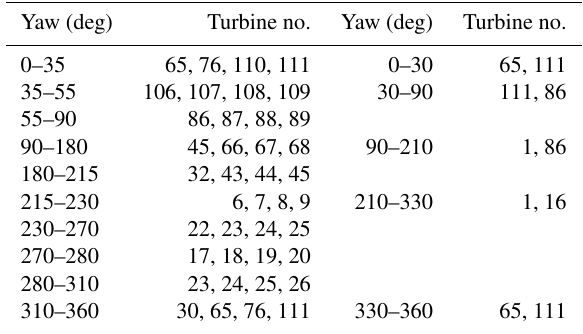
Table 1. Free-stream turbines used to determine the inflow wind speed (first two columns) and the inflow wind direction (second two columns) as a function of an average yaw position. Yaw (deg) Turbine no. Yaw (deg) Turbine